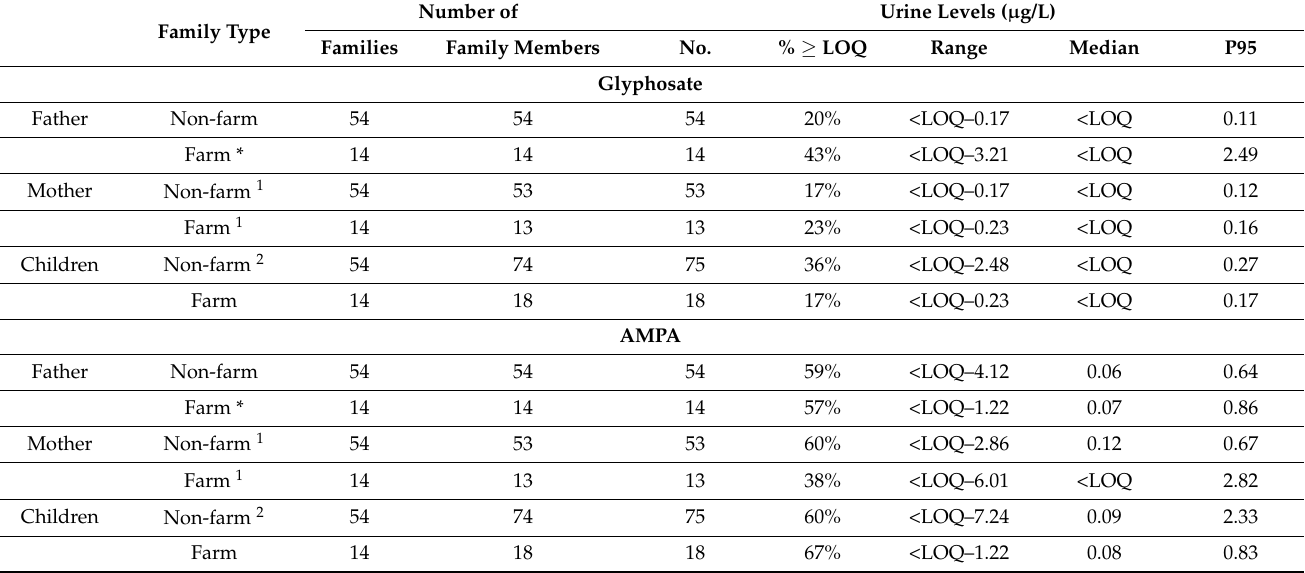
Table 2. Human biomonitoring. Biological monitoring results ( µ g/L) grouped as family type (farm/non-farm) and participant (father/mother/child), with the number of families and family members, and describing the number of urinary samples, the percentage of quantifiable samples, range, median and P95.